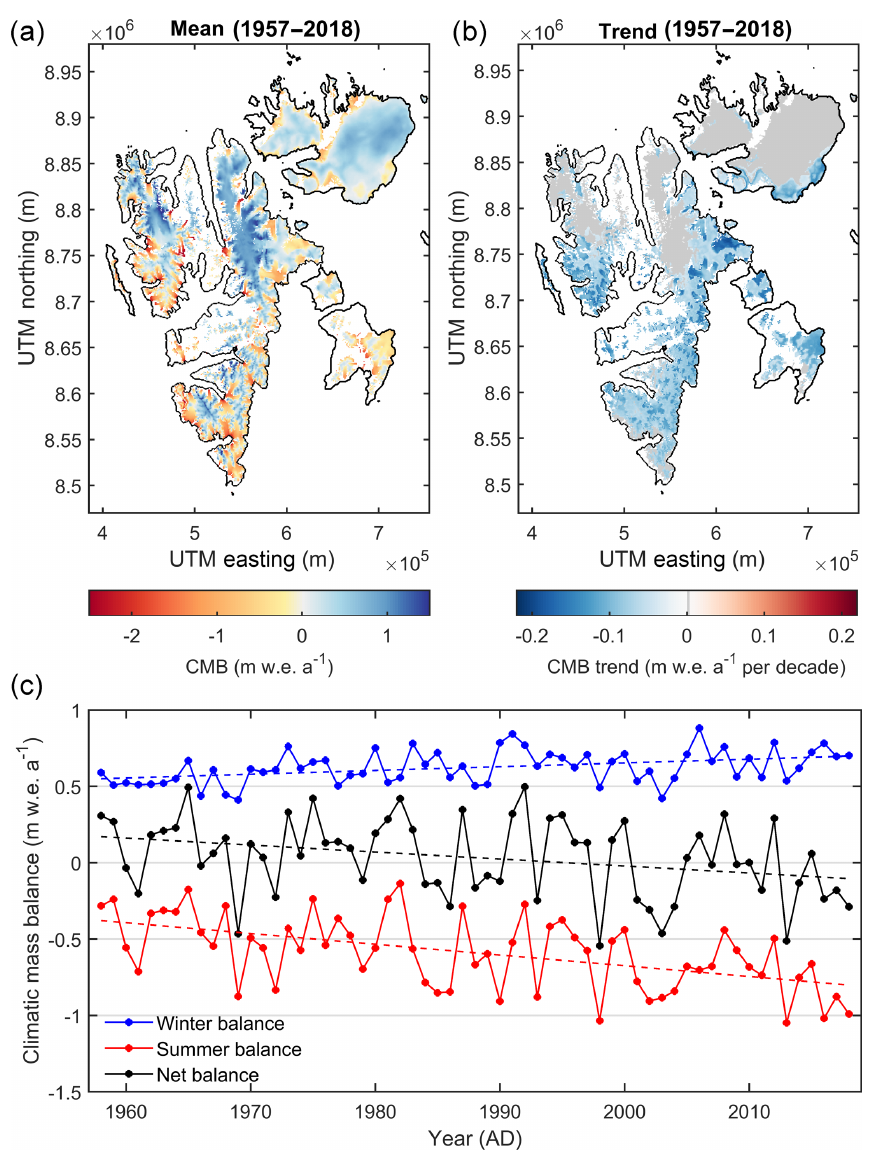
Figure 5. Long-term mean spatial CMB distribution (a) and trends (b) . In (c) time series of area-averaged annual mean summer, winter, and net CMB (solid lines) and linear trends (dashed lines) are shown. In (c) years are defined based on a mass balance year between 1 September (preceding year) and 31